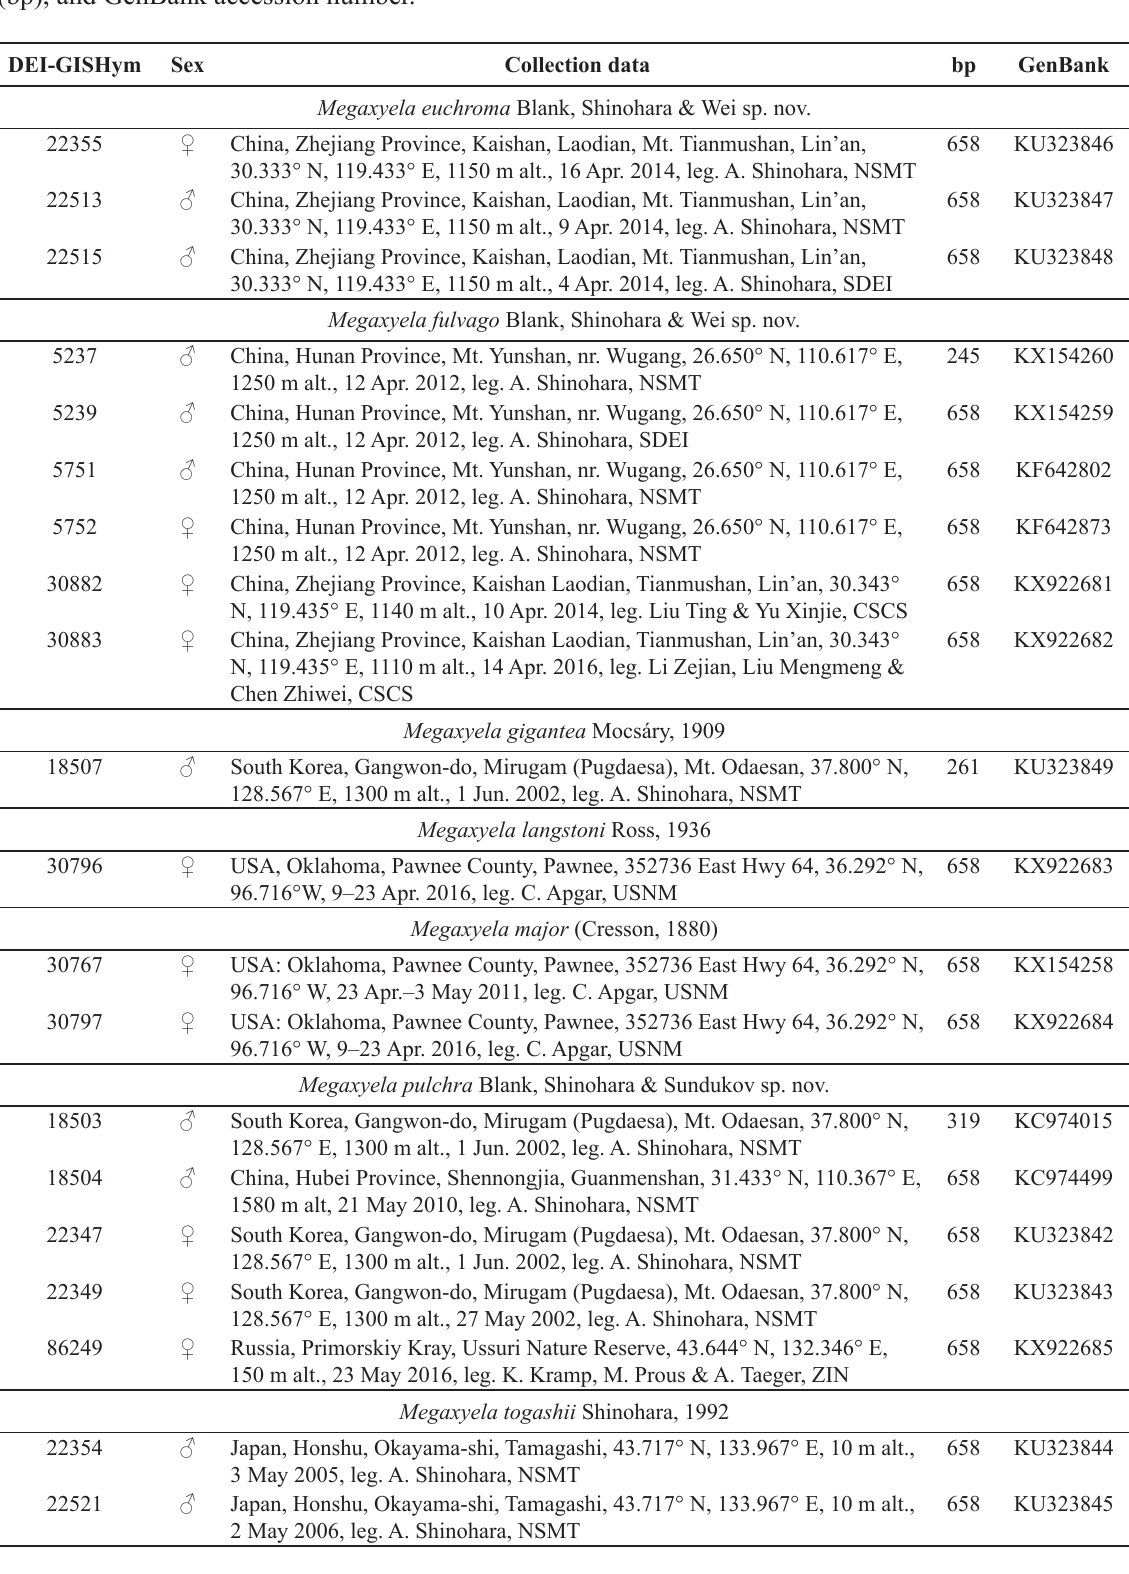
Table 1. COI sequences of Megaxyela species analyzed in this work, with specimen identifier (DEI- GISHym number), sex, collection data (including deposition of the voucher), length of COI-5P sequence (bp), and GenBank accession